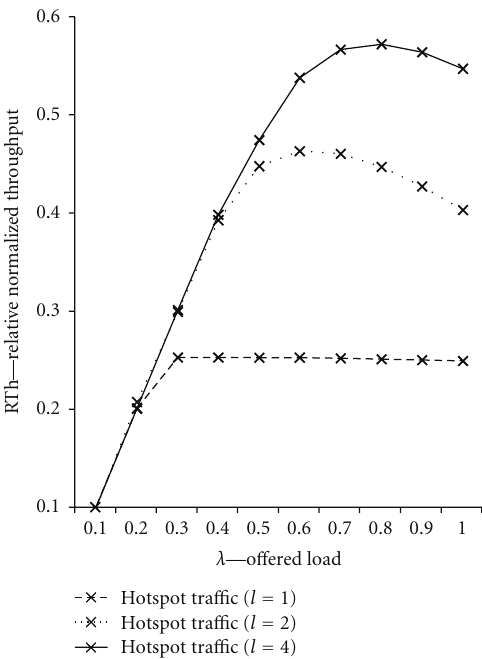
Figure 9: Relative normalized throughput for di ff erent numbers of layers at the final stage of the